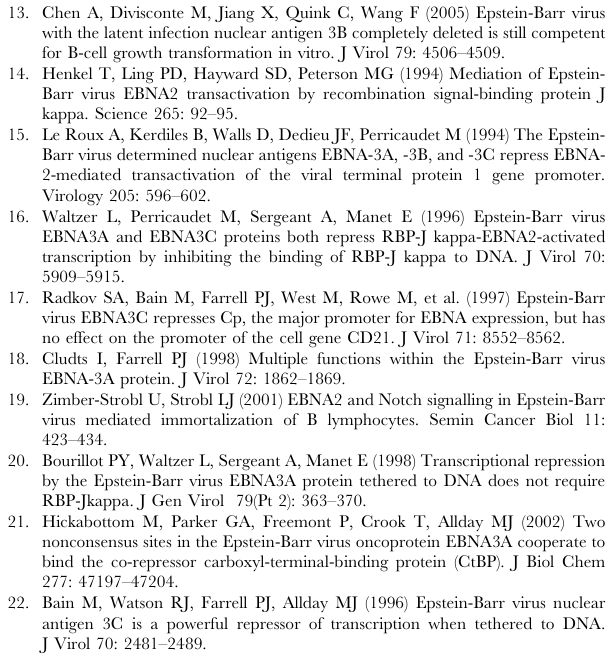
Table S9 Genes previously characterised in EBNA3B-knockout LCLs. Fold changes previously described by Chen et al (2006) for 3B-3Clow LCLs by qPCR and U133 microarray are compared to gene level changes from our 3BKO LCLs vs wtBAC-LCLs in our Exon microarray. The highly significantly regulated genes (p , 0.001) by microarray are also tested by qPCR, both on the same RNA and on an independent RNA sample. qPCR fold changes assume assays are 100% efficient. Genes whose names have changed since Chen et al (2006) are CLINT1 (formerly ENTH), PIK3R5 (formerly P101-PI3K) ARL6IP5 (formerly JWA) and TIAM1 (formerly U90902.1).